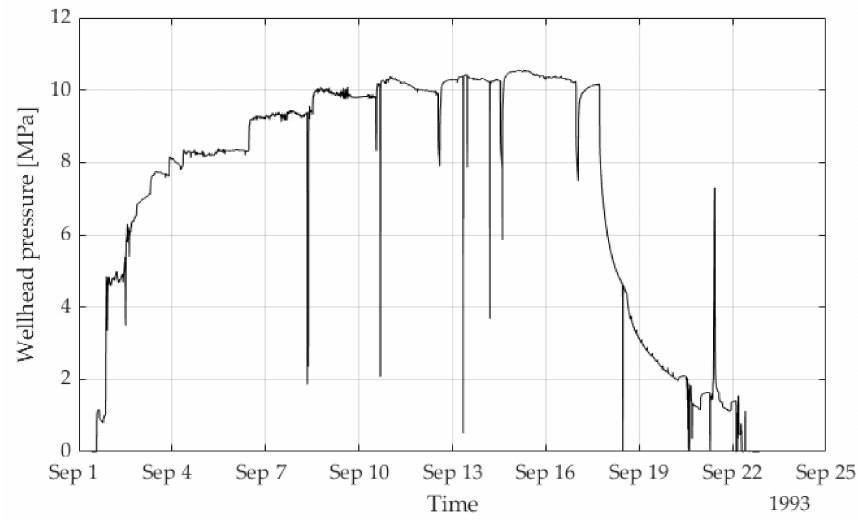
Figure 2. Wellhead pressure of GPK-1 Soultz 1993 injection